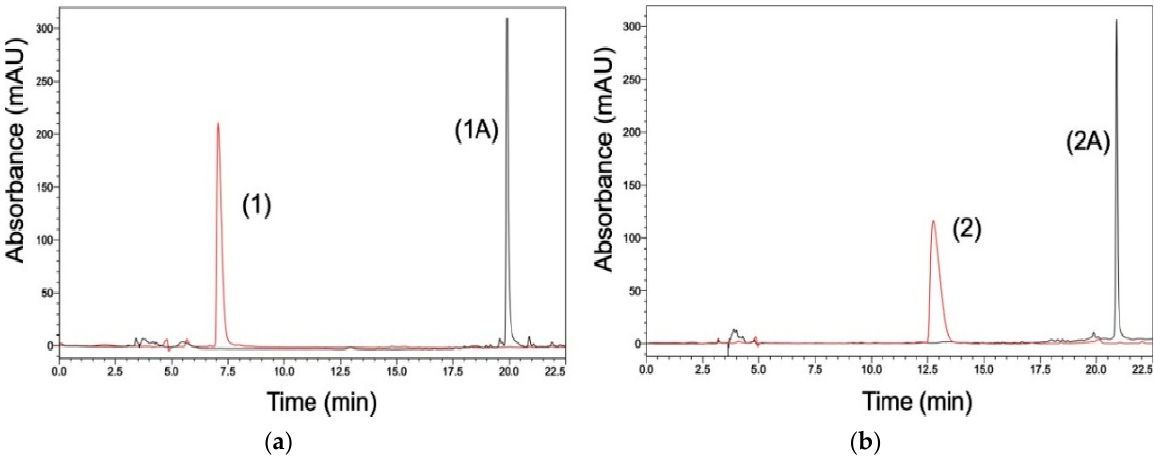
Figure 4. HPLC analysis of incubation 1 ( a ) and 2 ( b ) in D 2 O buffer (25 mM NaCl/25 mM K 3 PO 4 ), pH 6, temp. 25 °C. In each panel, the red run demonstrates the starting point ( 1 or 2 ) and the black run the end of incubation, showing the products assigned as 5-( R )-hydroxymethyl-7-ethyl- 10-hydroxycamptothecin 1A or its diastereomer 5-( S ) 2A . The fraction retention times were 7.4 min ( 1 ), 12.5 min ( 2 ), 19.8 min ( 1A ), and 21.0 min ( 2A ).